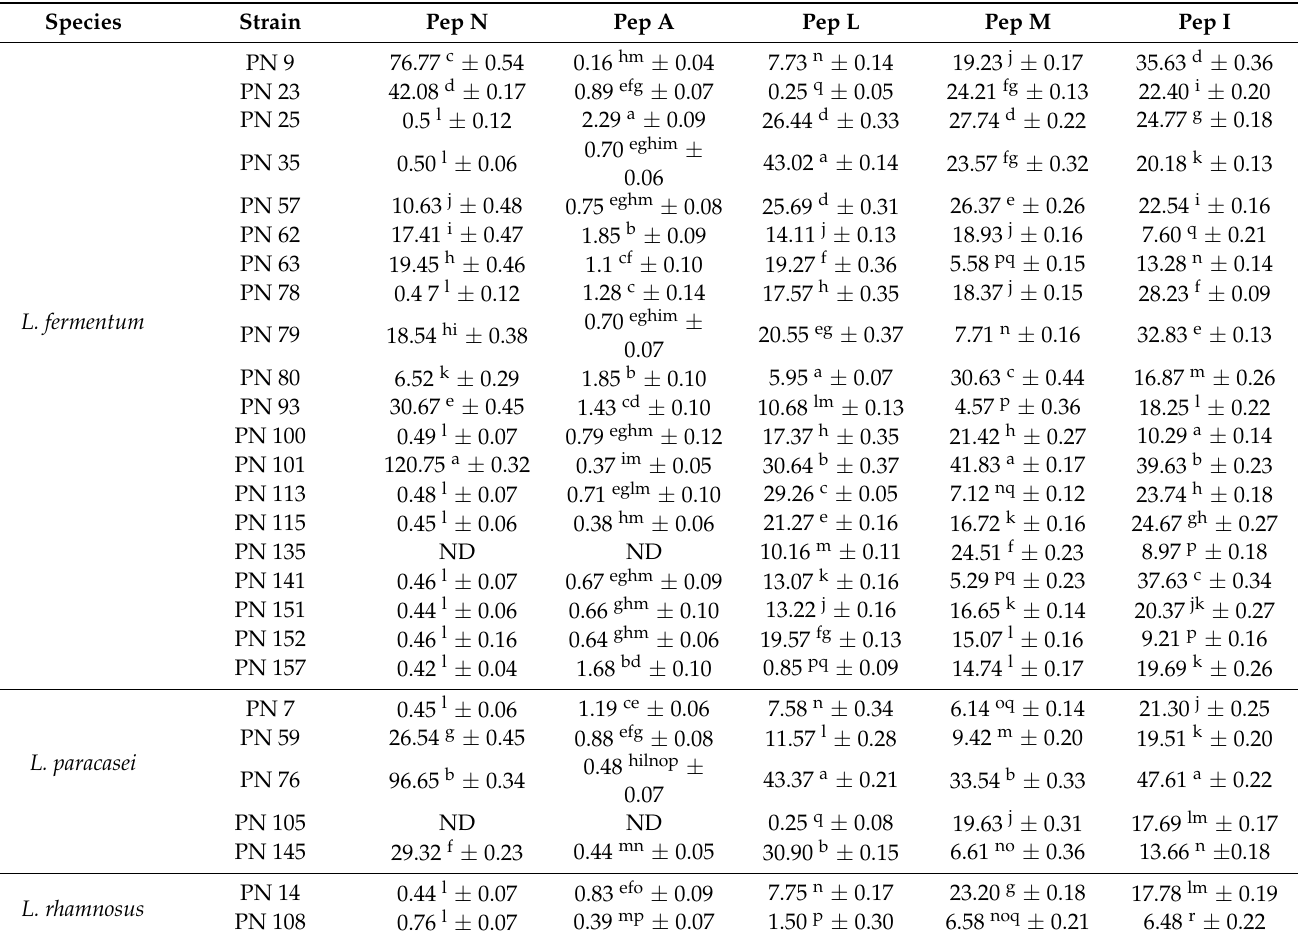
Table 3. Peptidase activities of the NSLAB